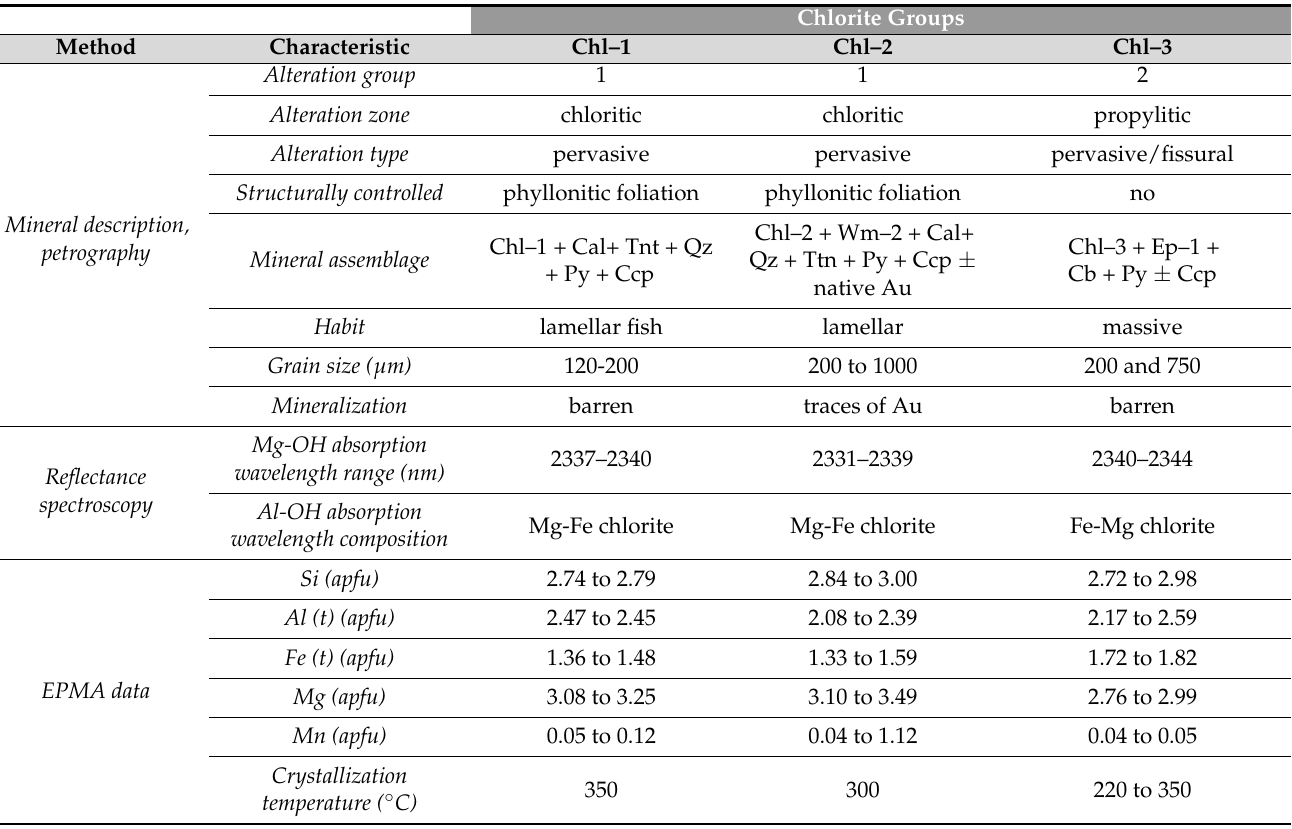
Table 3. Summary of the three chlorite groups of the Para í ba deposit, based on the mineral character- istics, drill-core logging, petrography, reflectance spectroscopy, and EMPA-derived data based on 14 oxygens. Chl–1 in samples BH059-041 and BH059-046; Chl–2 in sample BH020-027; and Chl–3 in sample